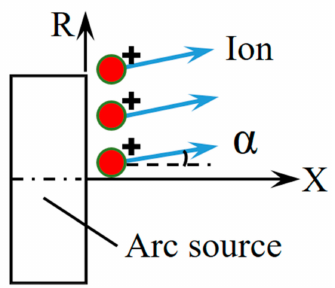
Figure 3. Schematic diagram of ion’s initial velocity